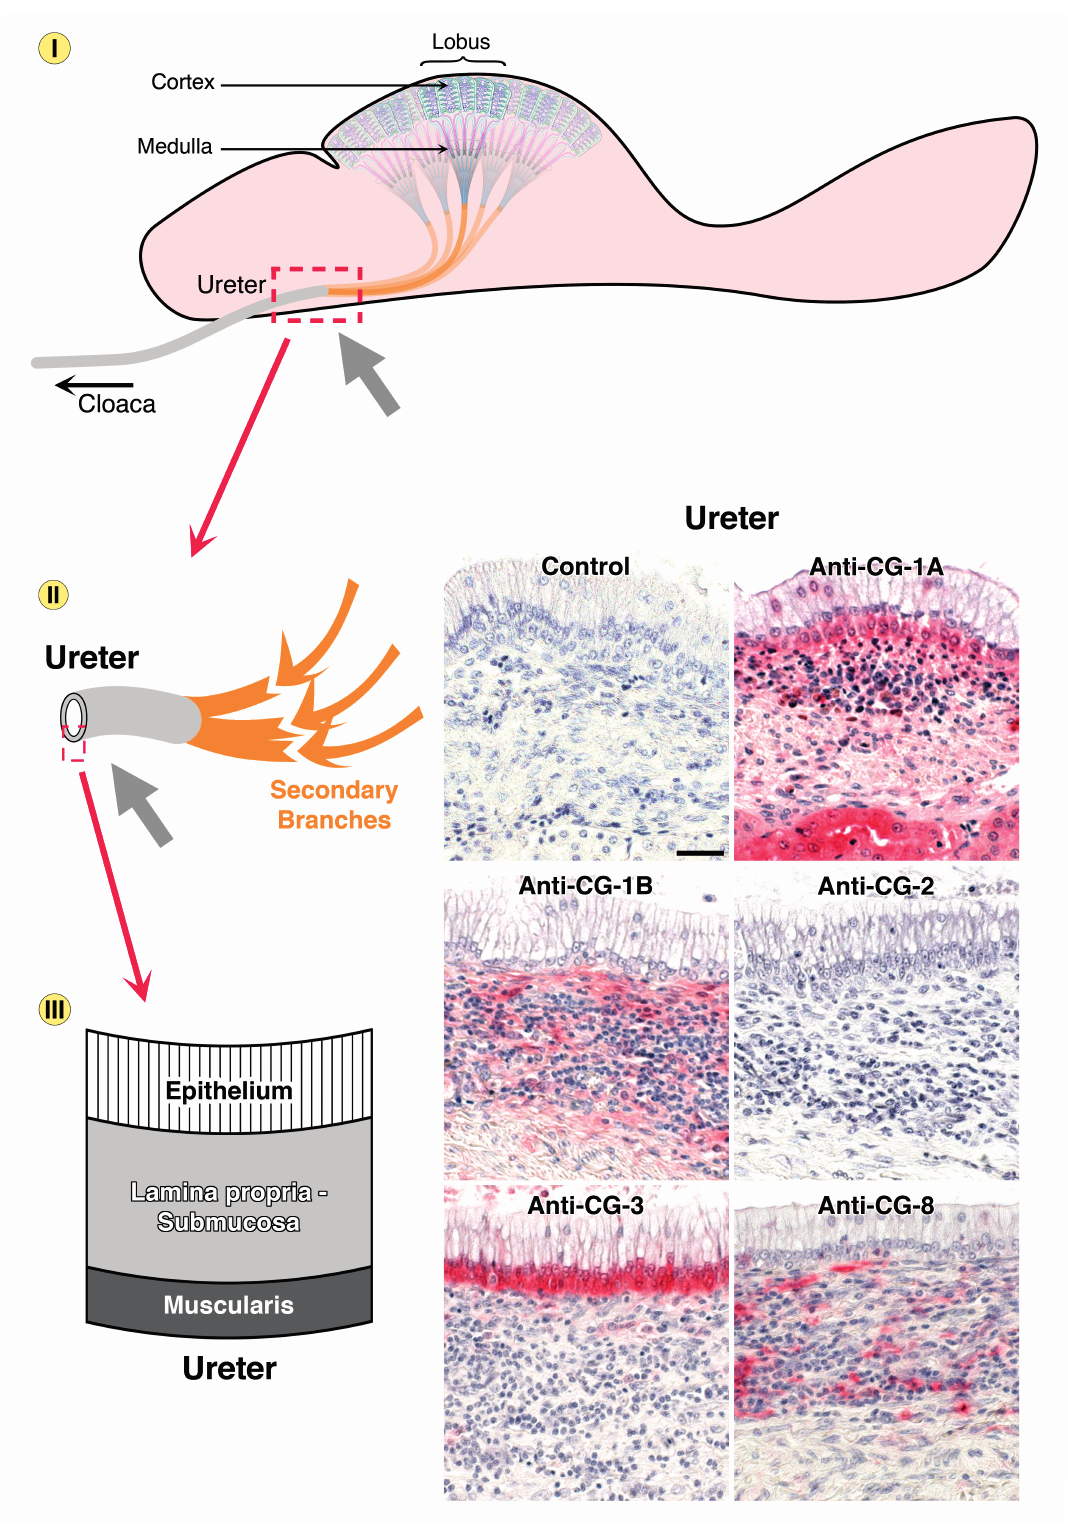
Figure 9. Schematic illustration of the chicken urinary system with focus on the ureter and its branches (top, grey arrow). Urine from secondary branches reaches the ureter constituted histomorphologically by the three parts given (left, bottom). CG-3 positivity was confined to the infranuclear portion of epithelial cells, CG-1B/CG-8 to connective tissue, while CG-1A was detected in all three layers (bar = 25